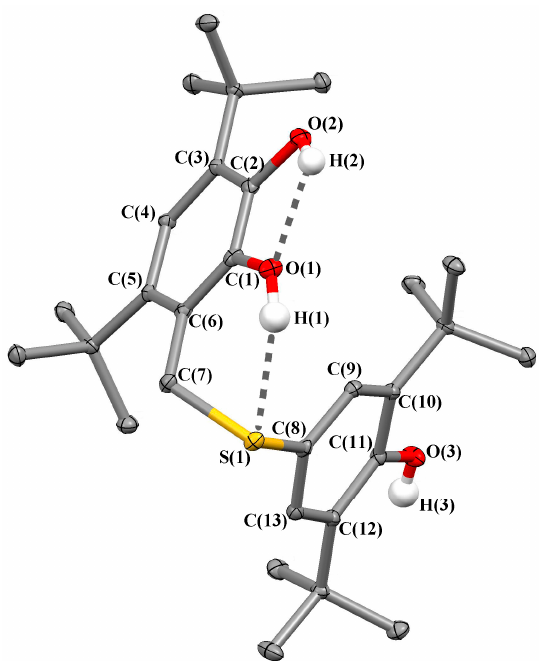
Figure 1. The X-ray structure of catechol L 1 (6-(CH 2 -S-tBu 2 Phenol)-3,5-DBCat)H 2 in crystal. The hydrogen atoms except hydroxyl hydrogens are omitted for clarity. The ellipsoids of 50% probability. The selected bond distances (Å): O(1)-C(1) 1.3816(14), O(2)-C(2) 1.3804(14), O(3)-C(11) 1.3806(14), S(1)-